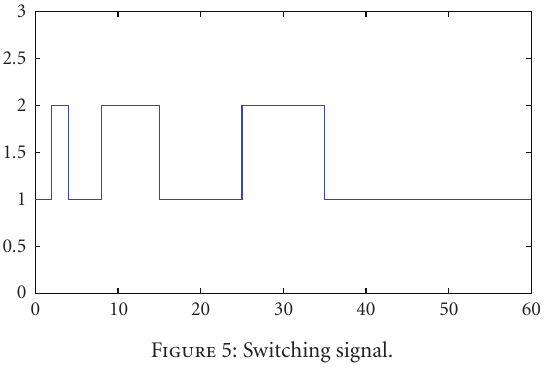
Figure 5: Switching signal.